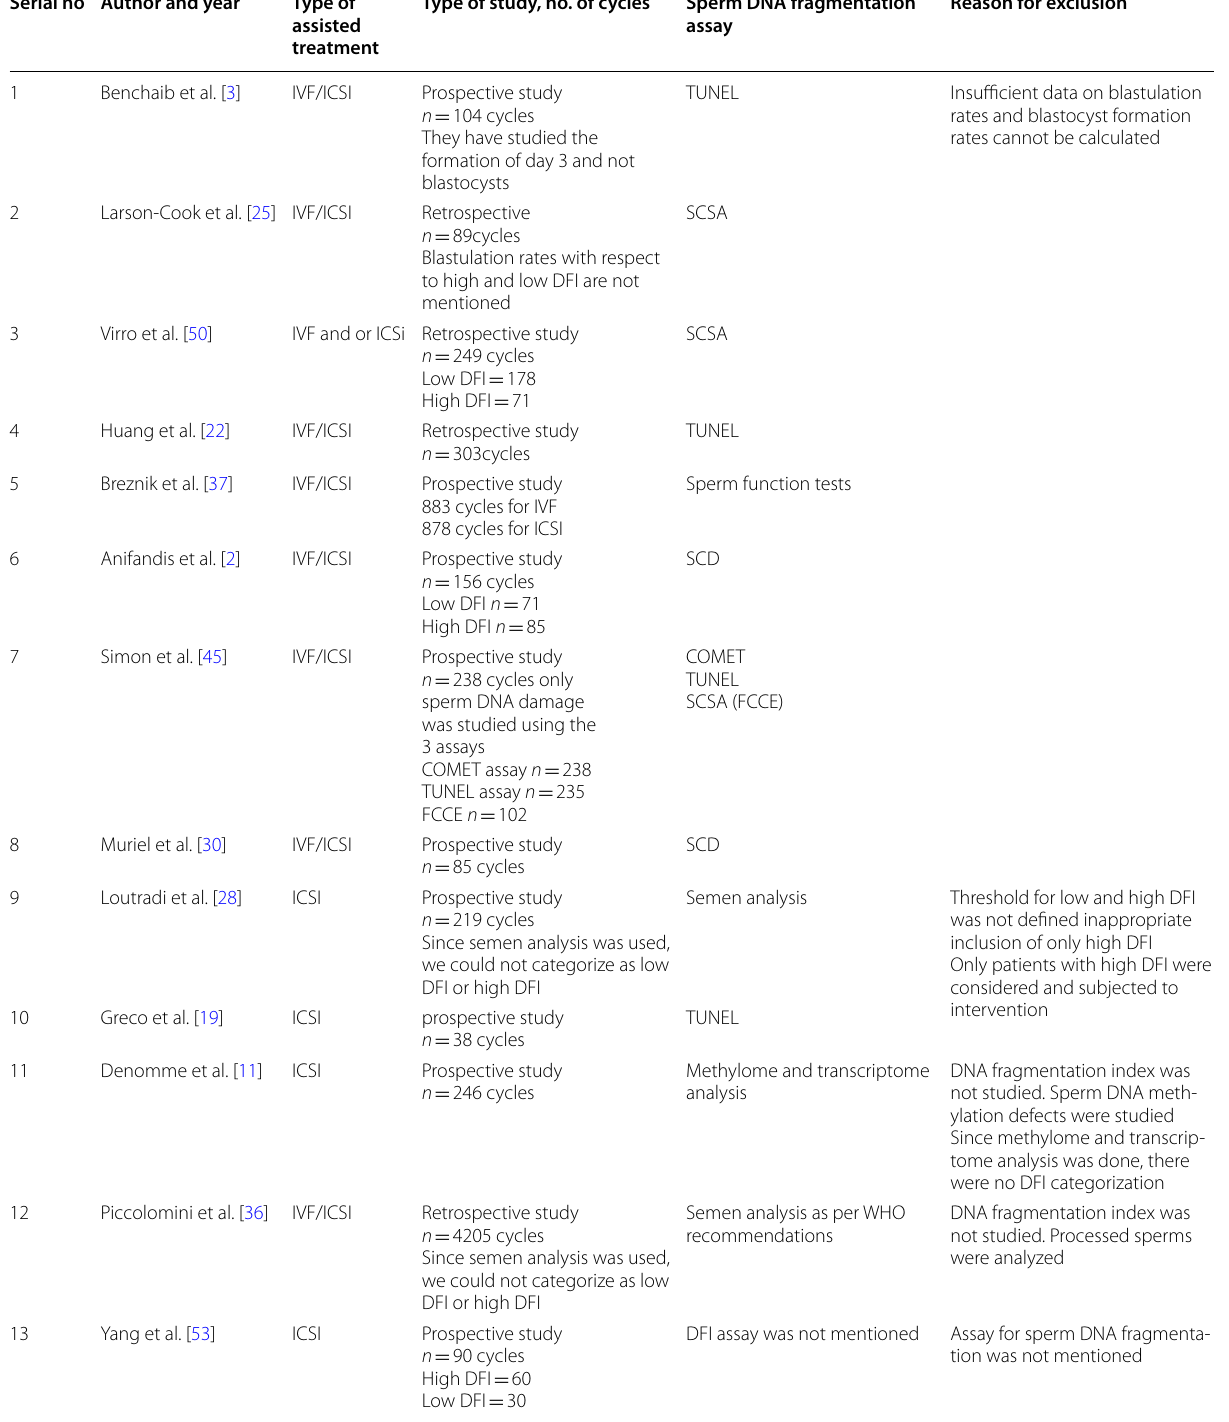
Table 2 Study characteristics (excluded